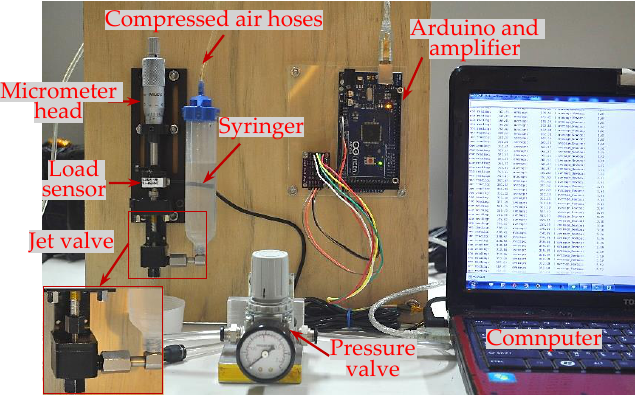
Figure 5. Experimental setup used to measure resistance force acting on jet valve needle during operation.